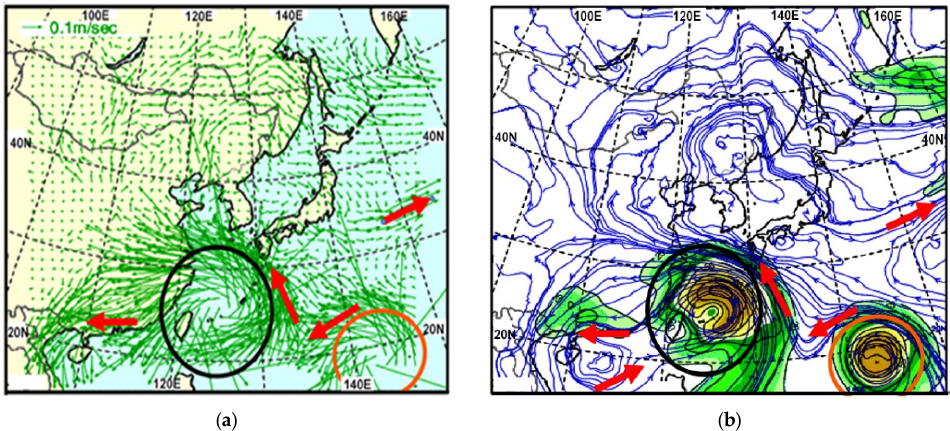
Figure 23. As shown in Figure 4, except for ( a ) moisture flux (0.1 ∙ kg.m/s) and ( b ) streamline with isotaches (green ‐ color areas greater than 25 kt) at 850 hPa (1.5 km height) at 09:00 LST, 10 July 2015. TY Chan ‐ Hom interacted with TY Nangka and an MLCT resulting in northward movement. As STS